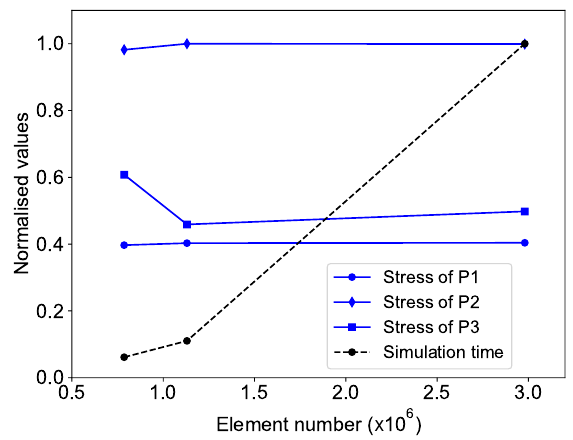
Figure 14. Mesh sensitivity